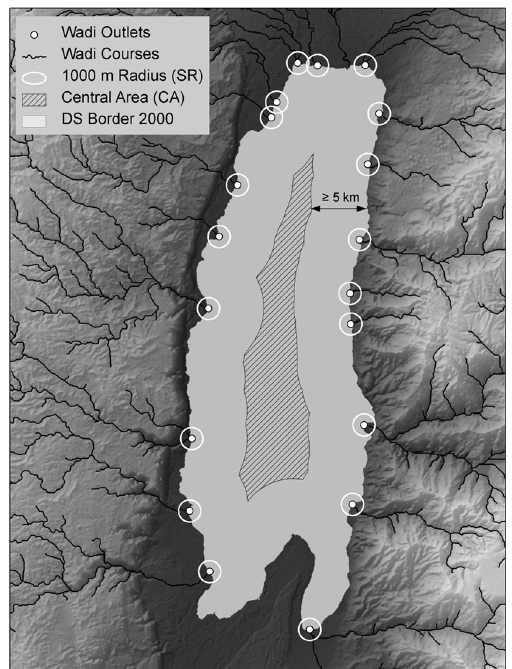
Figure 4. Wadi outlets and investigated outlet radii that are de- rived using a crosspoints analysis with calculated flow paths and DS boundary and the derived central area of the DS with a mini- mum distance of 5km from any point of the DS